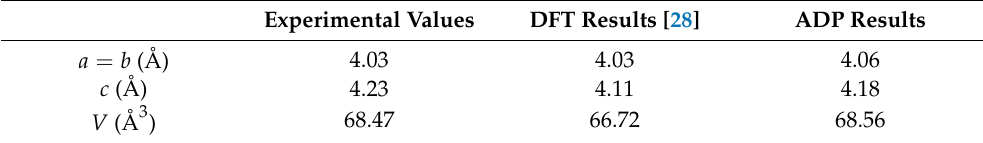
Figure 1. ( a )The force comparison between DFT calculation and ADP force field for KTN. ( b ) The energy comparison between DFT calculation and ADP force field for KTN. Table 1. Comparison of lattice constant between ADP results and previous DFT results.